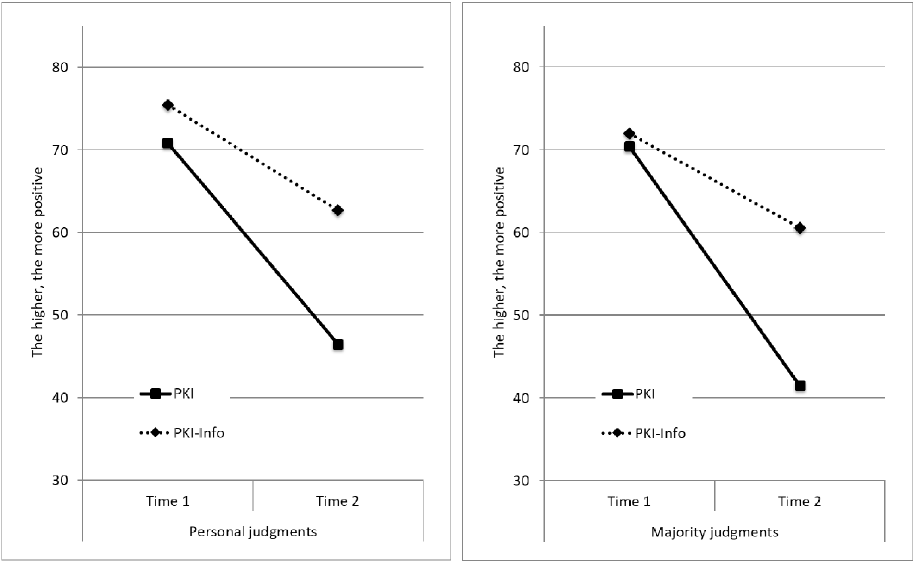
Figure 3. Mean estimates of positive judgments in Study